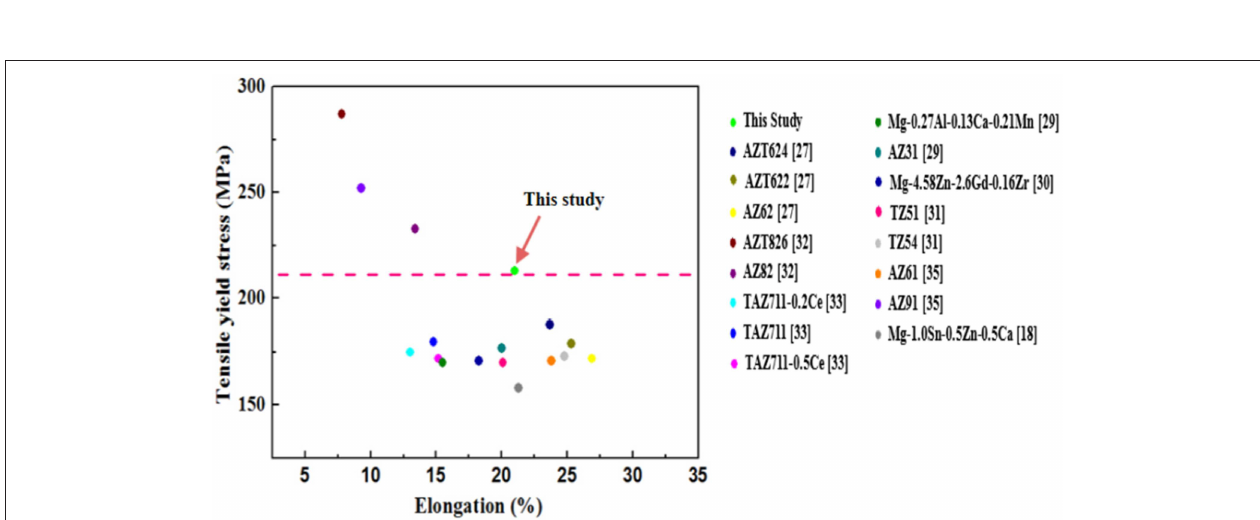
FIGURE 7 | The comparison of tensile properties among the extruded dilute TMX-1.0 alloy with other Mg-based extruded alloys.